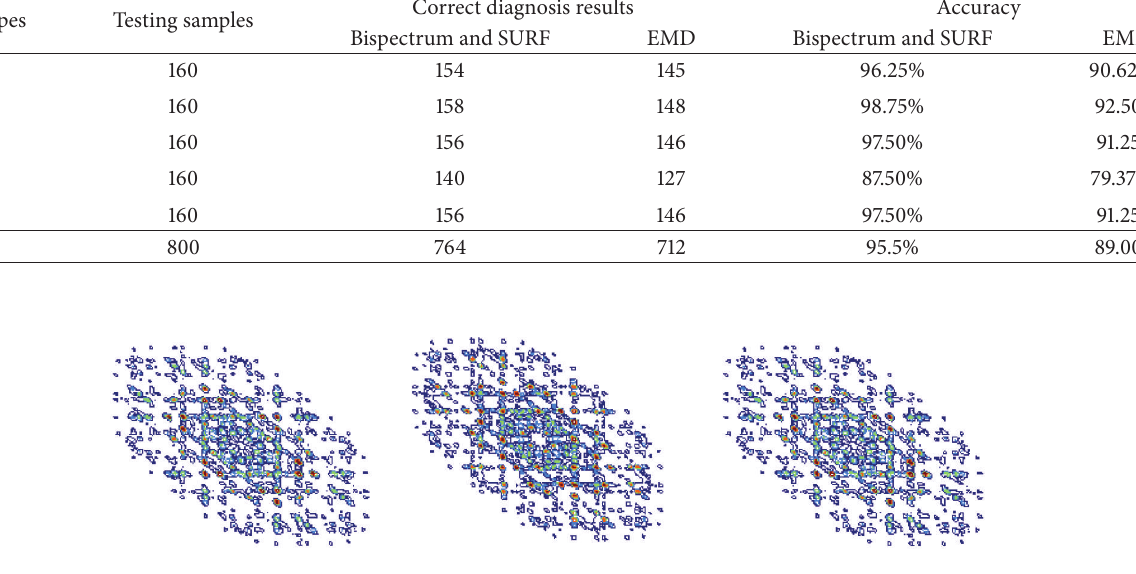
Figure 11: Bispectrum contour map of fault 3.